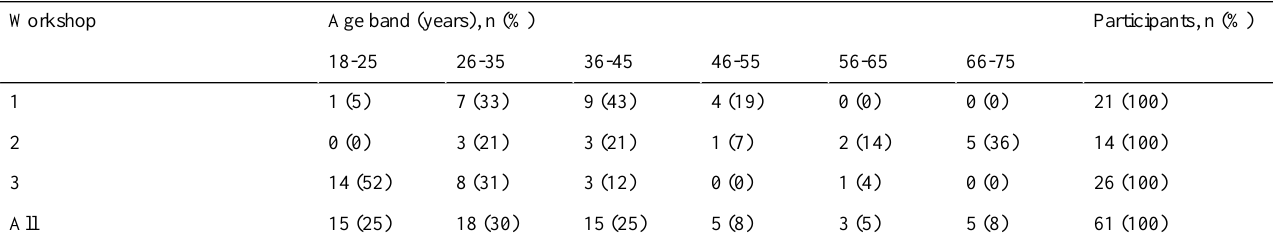
Table 1. Numbers of public workshop participants in age bands.